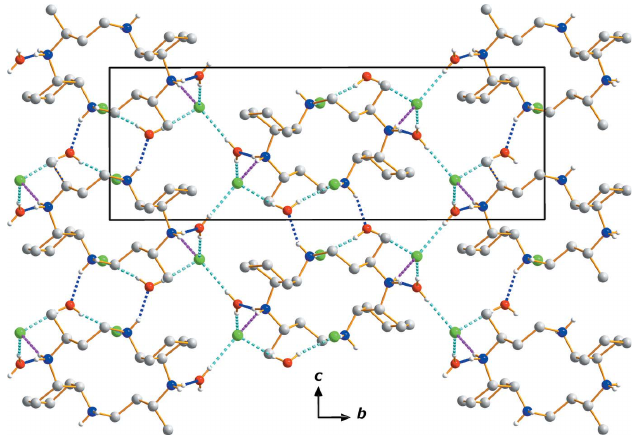
Figure 2 The crystal packing in compound (I), viewed perpendicular to the bc plane. Dashed lines represent N—H (cid:2)(cid:2)(cid:2) O (blue), N—H (cid:2)(cid:2)(cid:2) Cl (pink) and O—H (cid:2)(cid:2)(cid:2) Cl (cyan) hydrogen-bonding interactions, respectively. C-bound H atoms have been